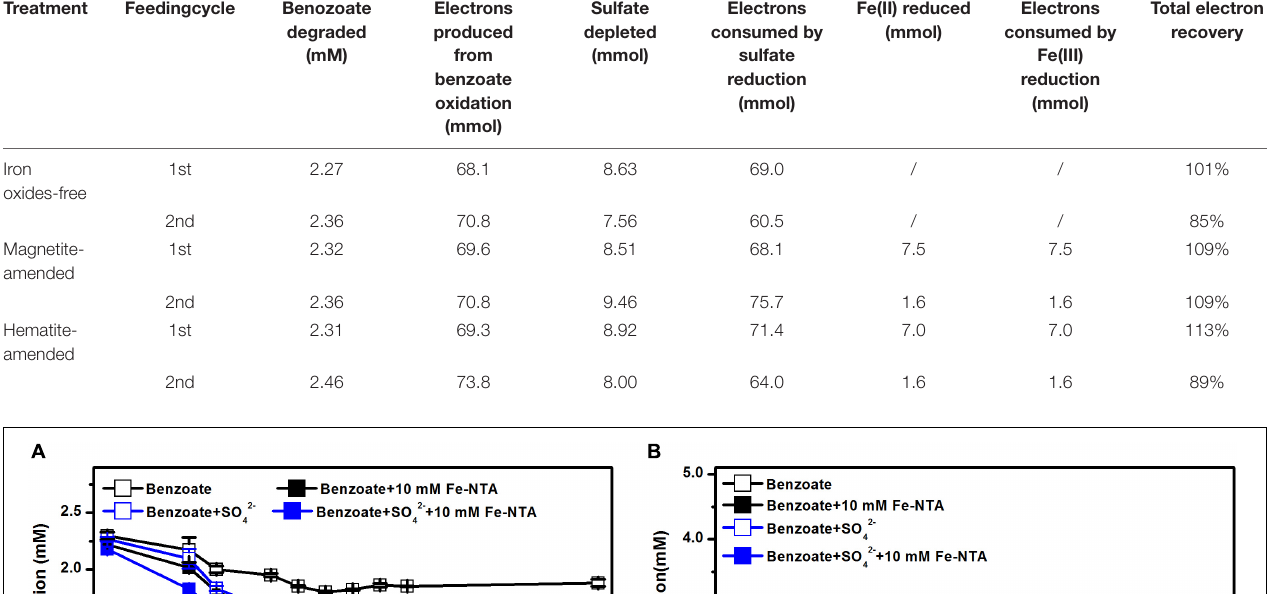
Treatment Feedingcycle